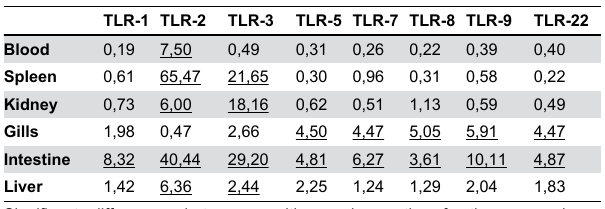
Table 3. Ratio of TLR transcription in IgM + cells in comparison to levels detected in the corresponding negative fractions (IgM + : IgM - ).